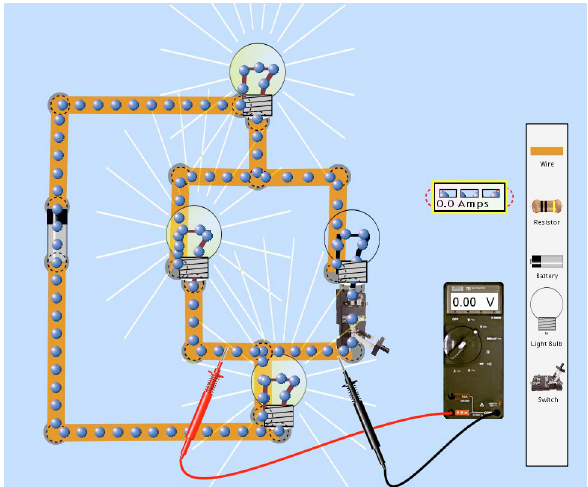
FIG. 1. (cid:1) Color (cid:2) Screenshot of the Physics Education Technology project simulation, Circuit